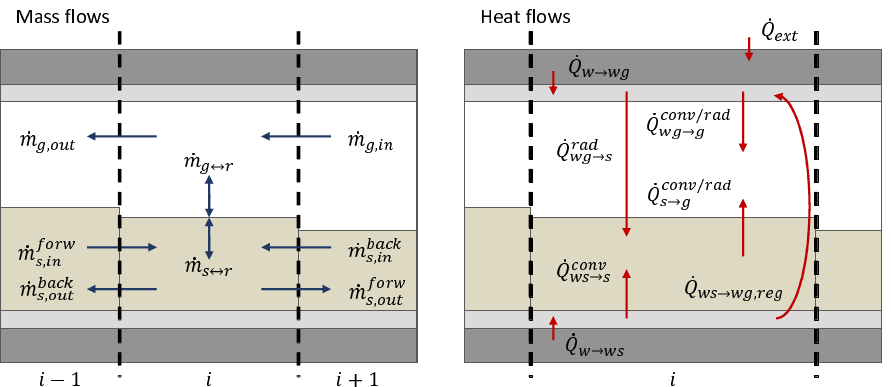
Figure 8. Modelled mass flows between the phases and the compartments ( left ) and heat flows due to different transfer mechanisms between the phases ( right